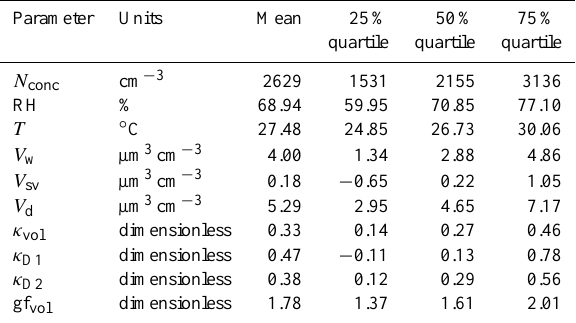
Table 1. Mean and quartiles of number concentration N conc , rela- tive humidity RH, temperature T , particle-phase water volume V w , semi-volatile volume Vsv lost during drying, volume of solutes V d , hygroscopicity parameters κ vol , κ D1 , and κ D2 , and volumetric growth factor gf vol